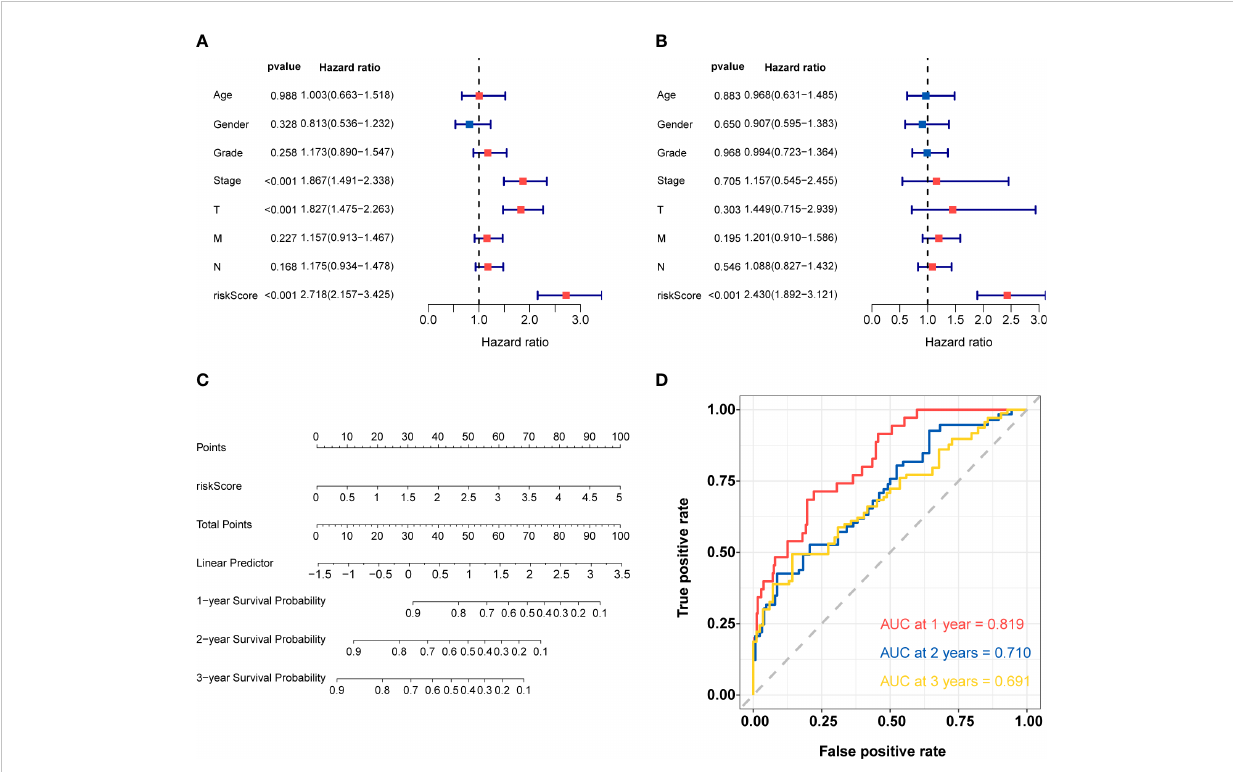
FIGURE 6 Construction and validation of nomogram (A) Univariate Cox regression analysis for risk score and other clinic pathological factors. (B) Multivariate cox regression analysis for risk score and other clinic pathological factors. (C) The nomogram for predicting 1-, 2-, and 3-years overall survival by risk score. (D) ROC curve analysis of nomogram according to the 1-, 2-, and 3-year overall